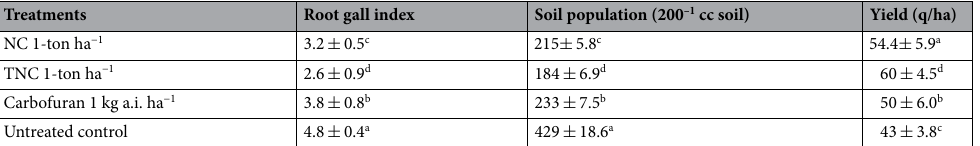
Table 4. Efficacy of T. asperellum FbMi6 enriched neem cake in okra against M. incognita . Data are mean of five replicates. INP- 235 J 2 /200 cc soil. Values with the different letter are significant according to DMRT (p < 0.05). Data are presented as means ± SD. NC neem cake; TNC T. asperellum FbMi6 enriched neem cake.